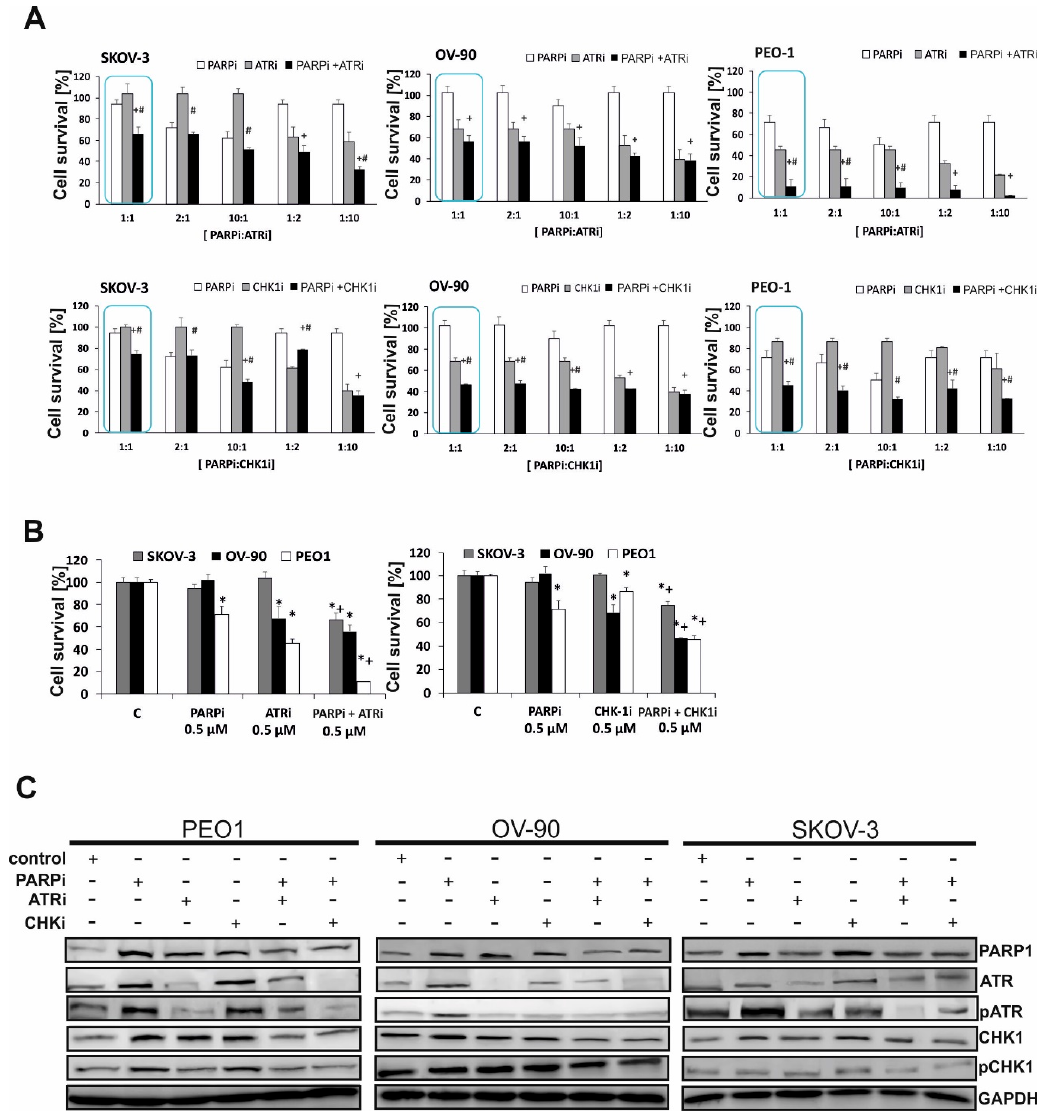
Figure 2. PARPi in combination with CHK1i or ATRi has a synergistic effect in ovarian cancer cells. ( A ) The effect of combination treatment with ATRi or CHK1i and PARPi at different ratios was evaluated by the MTT assay. In all cell lines, the combination of ATRi/PARPi had a synergistic effect compared with either drug alone (SKOV-3, CDI = 0.69; OV-90, CDI = 0.82; and PEO-1, CDI = 0.34). Similar effects were obtained with the combination of CHK1i/PARPi compared with either drug alone (SKOV-3, CDI = 0.79; OV-90, CDI = 0.66; and PEO-1, CDI = 0.74). ( B ) The combination effect of PARPi/ATRi and PARPi/CHK1i at 0.5 µM was evaluated by the MTT assay. * Statistically significant differences between samples incubated with the compound compared with control cells ( p < 0.05). + Statistically significant changes between samples incubated with PARPi and combination treatment (PARPi/ATRi; PARPi/CHK1i) ( p < 0.05). # Statistically significant differences between the samples incubated with ATRi or CHKi and combination treatment (PARPi/ATRi; PARPi/CHK1i) ( p < 0.05). ( C ) BRCA2 MUT (PEO-1) and HR-proficient (SKOV-3 and OV-90) cells were treated with PARPi, ATRi, CHK1i, and the combination of PARPi/ATRi or PARPi/CHK1i at 0.5 µM, and lysates were collected at 24 h. Western blot analysis of phosphorylated and total proteins was performed. PARP increased with PARPi by 4.9-fold in PEO-1 cells, 2.52-fold in OV-90 cells, and 2.3-fold in SKOV-3 cells. PARPi with ATRi decreased PARP by 1.43-fold in PEO-1 cells, 1.3-fold in OV-90 cells, and 1.1-fold in SKOV- 3 cells. PARPi with CHK1i decreased PARP by 1.7-fold in PEO-1 cells, 1.6-fold in OV-90 cells, and 1.1-